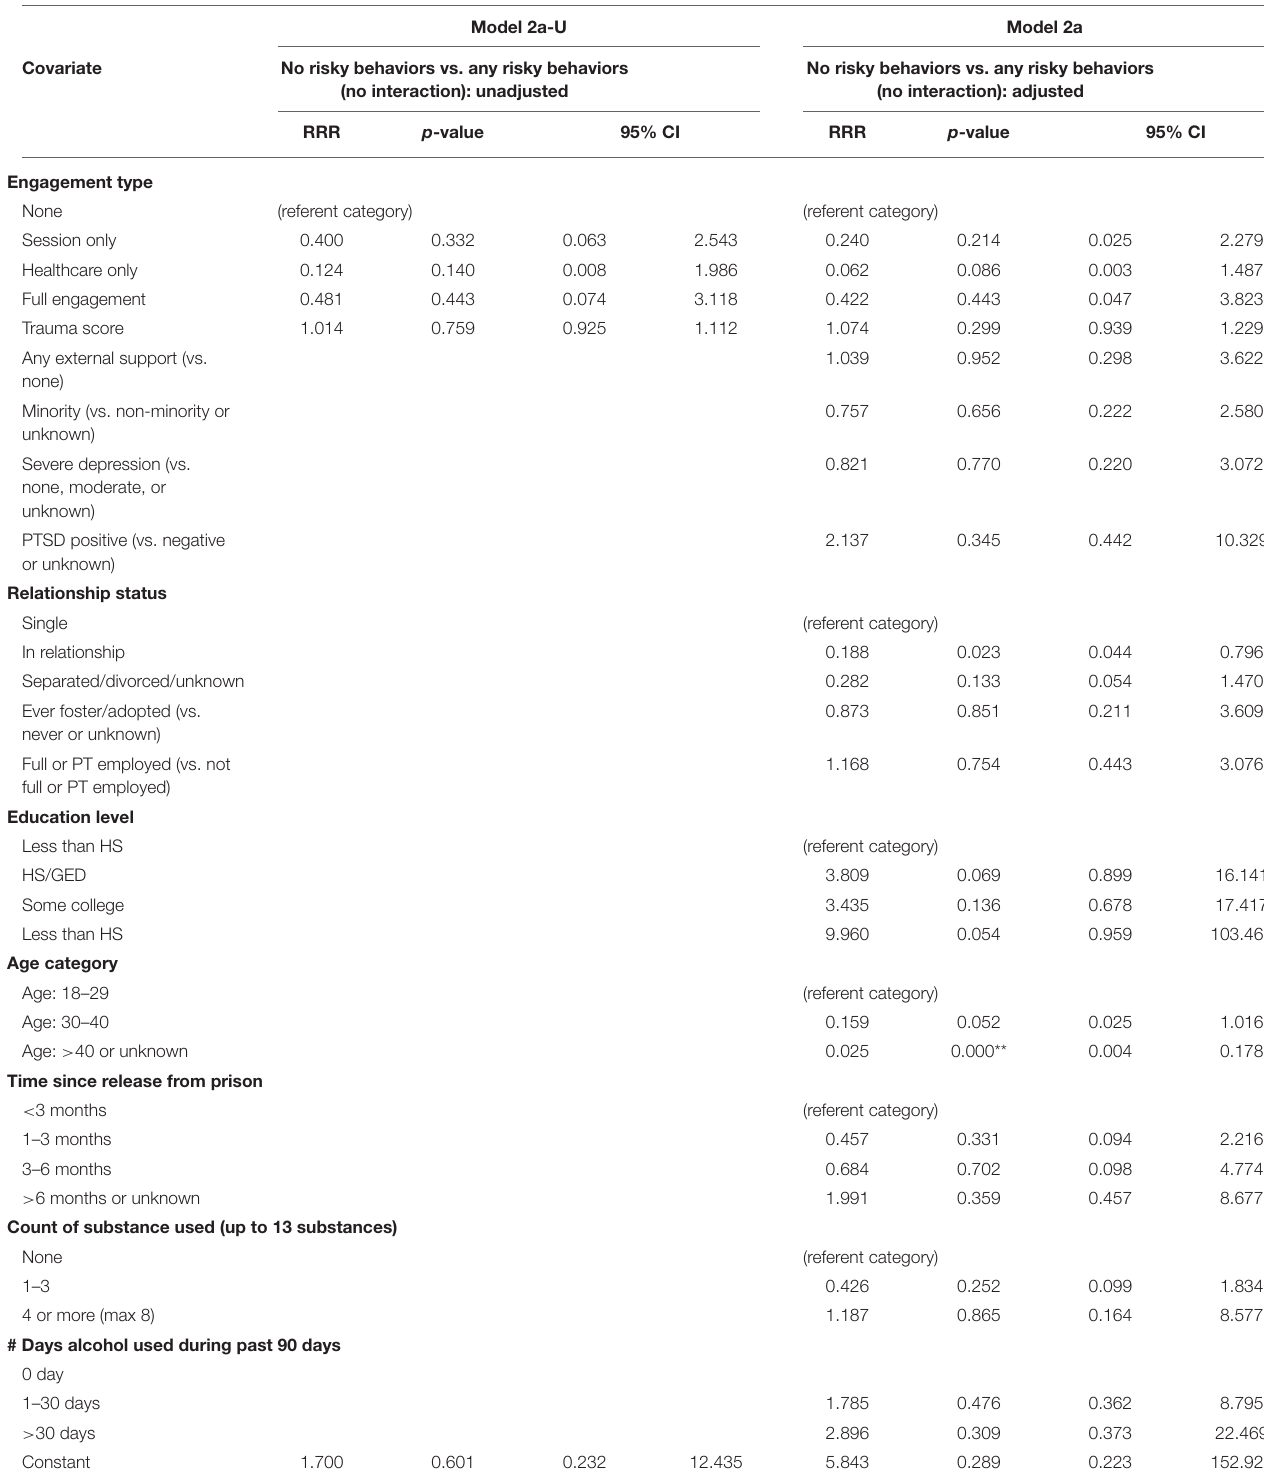
TABLE 4 | Longitudinal multivariate analysis trauma, psychopathology, and all other variables by HIV/STIs/HCV risk